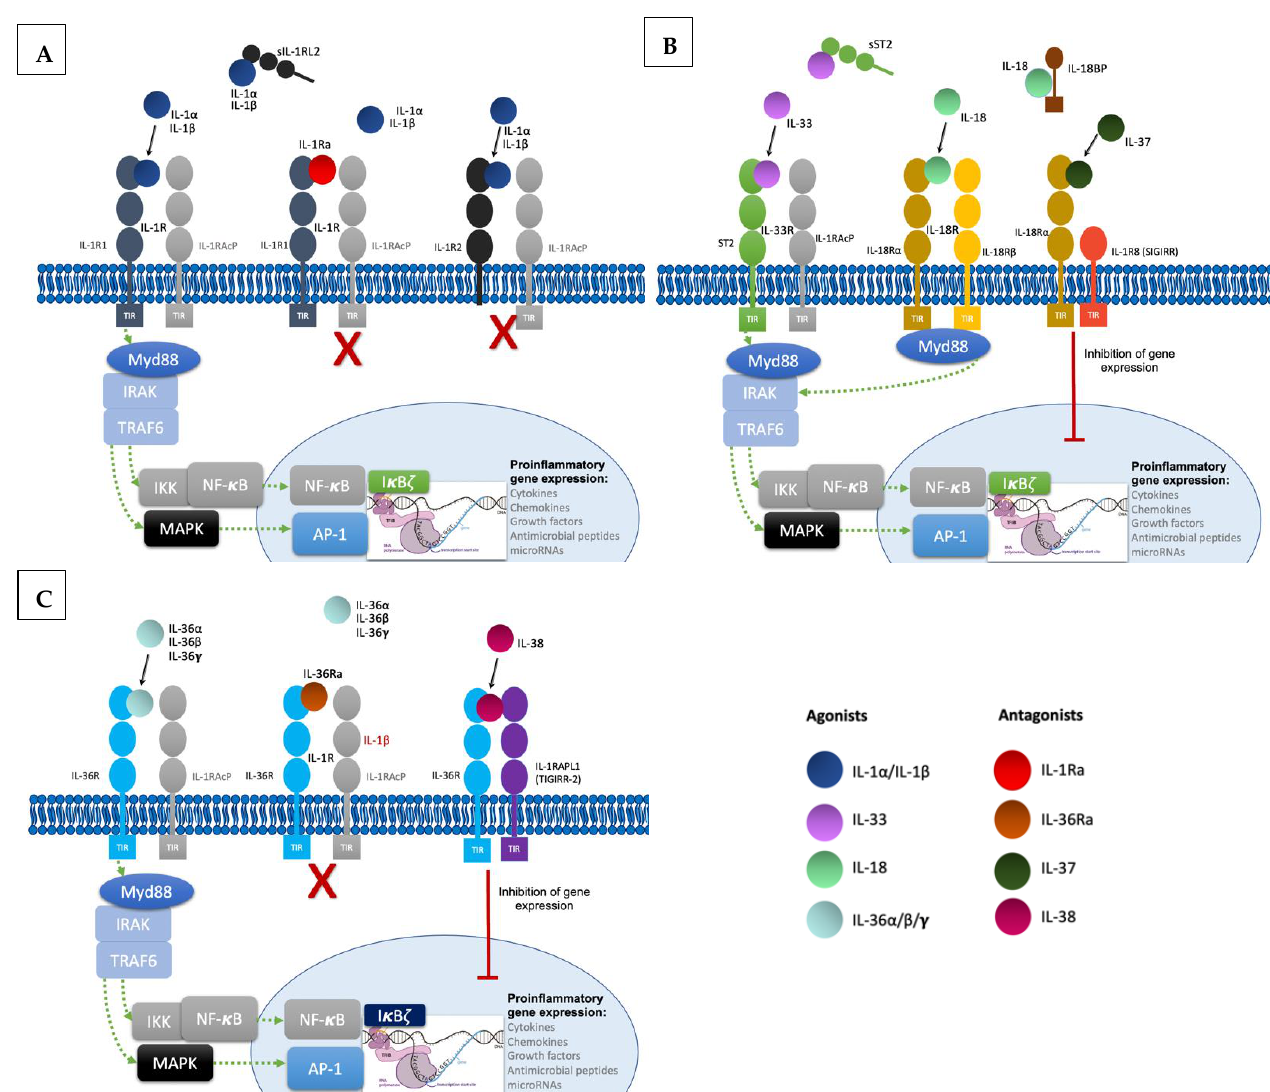
Figure 1. Signaling pathways and regulatory mechanisms involved in the IL-1 family . ( A ). Upon binding of IL-1α and IL-β to their receptor IL-1R1 altogether with co-receptor IL-1RAcP, induction of signal transduction with recruitment of myeloid differentiation primary response 88 (MyD88) accessory protein and IL-1R associated kinase (IRAK) proteins, ultimately ending in the activation of the transcription factor nuclear factor κB (NF- κB) and the transcription of proinflammatory genes. Regulatory mechanisms include IL-1R2 and IL-1Ra: IL-1R2 can exist as a soluble receptor or membrane bound, acting as a decoy receptor as it is unable to recruit the co-receptor to induce signal transduction. Finally, IL-1Ra acts as a competitive inhibitor by binding to IL-1R1. ( B ). Likewise, IL-33 binds to the receptor ST2, inducing the recruitment of co-receptor IL-1RAcP and resulting in signal transduction into the nucleus with transcription of proinflammatory genes. In this family, the soluble form of ST2 also acts as a decoy receptor. IL-18 binds to IL-18Rα and recruits the co-receptor IL-18Rβ resulting in pro-inflammatory signaling. IL-18 binds to the soluble protein IL-18BP preventing binding to the receptor. IL-37 is an anti-inflammatory cytokine and upon binding to IL-18Rα induces recruitment of the Single Ig and TIR Domain Containing (SIGIRR or IL-1R8), ultimately producing inhibitory signaling. ( C ). IL-36 cytokines also induce pro-inflammatory gene transcription by binding to the receptor IL-36R and recruiting co-receptor IL-1RAcP. IL-36Ra is the competitive antagonist of IL-36 cytokines. The anti-inflammatory cytokine IL-38 forms a complex with IL-36R and three immunoglobulin domain-containing IL-1 receptor-related 2 (TIGIRR-2 or IL1RAPL1), also inducing inhibitory signaling to regulate the pro-inflammatory gene activation.